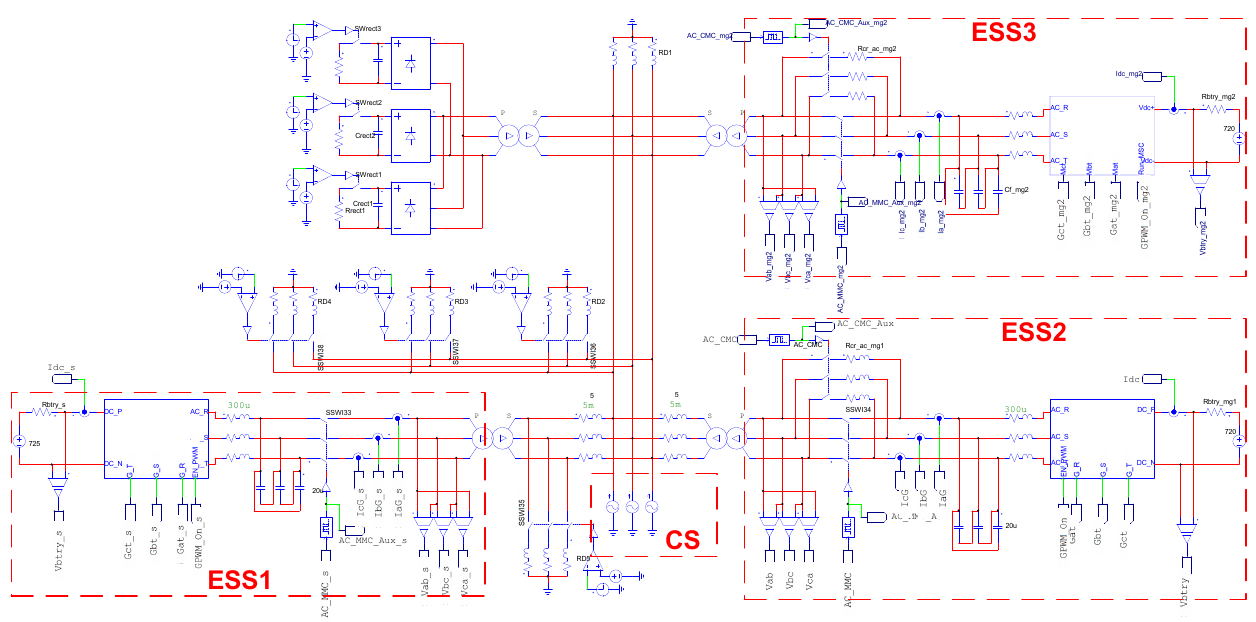
Figure 7. PSIM simulation model: MG circuit.